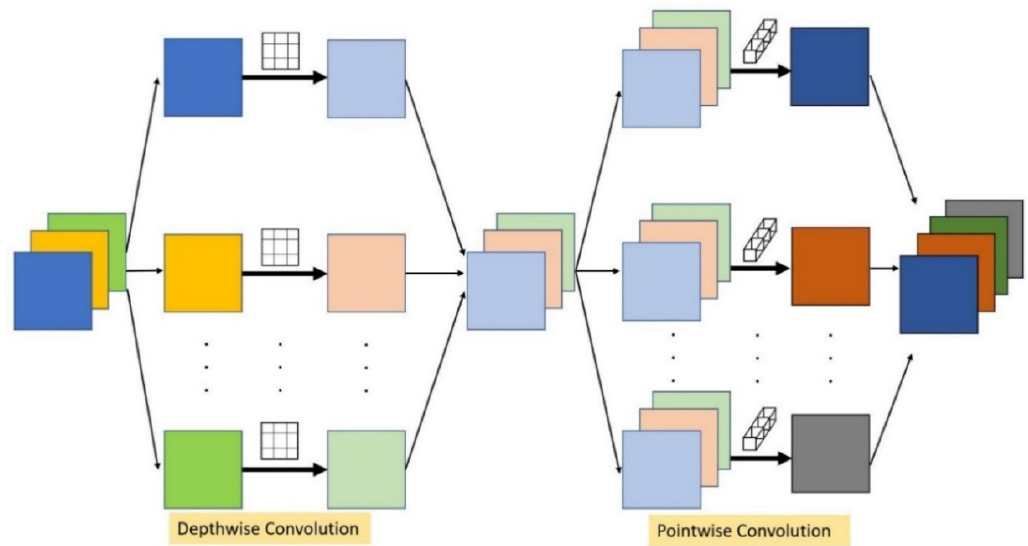
Figure 3. Explanatory drawing of the depthwise separable convolution operation.